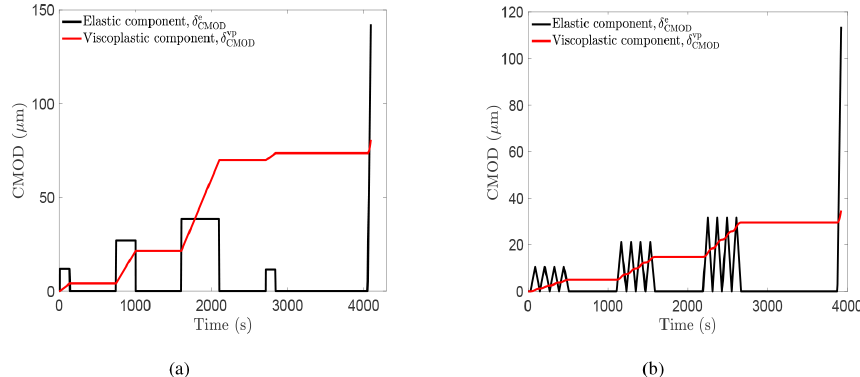
Figure 11. Contribution of each individual model component to the total CMOD displacement for (a) RP16 and (b)